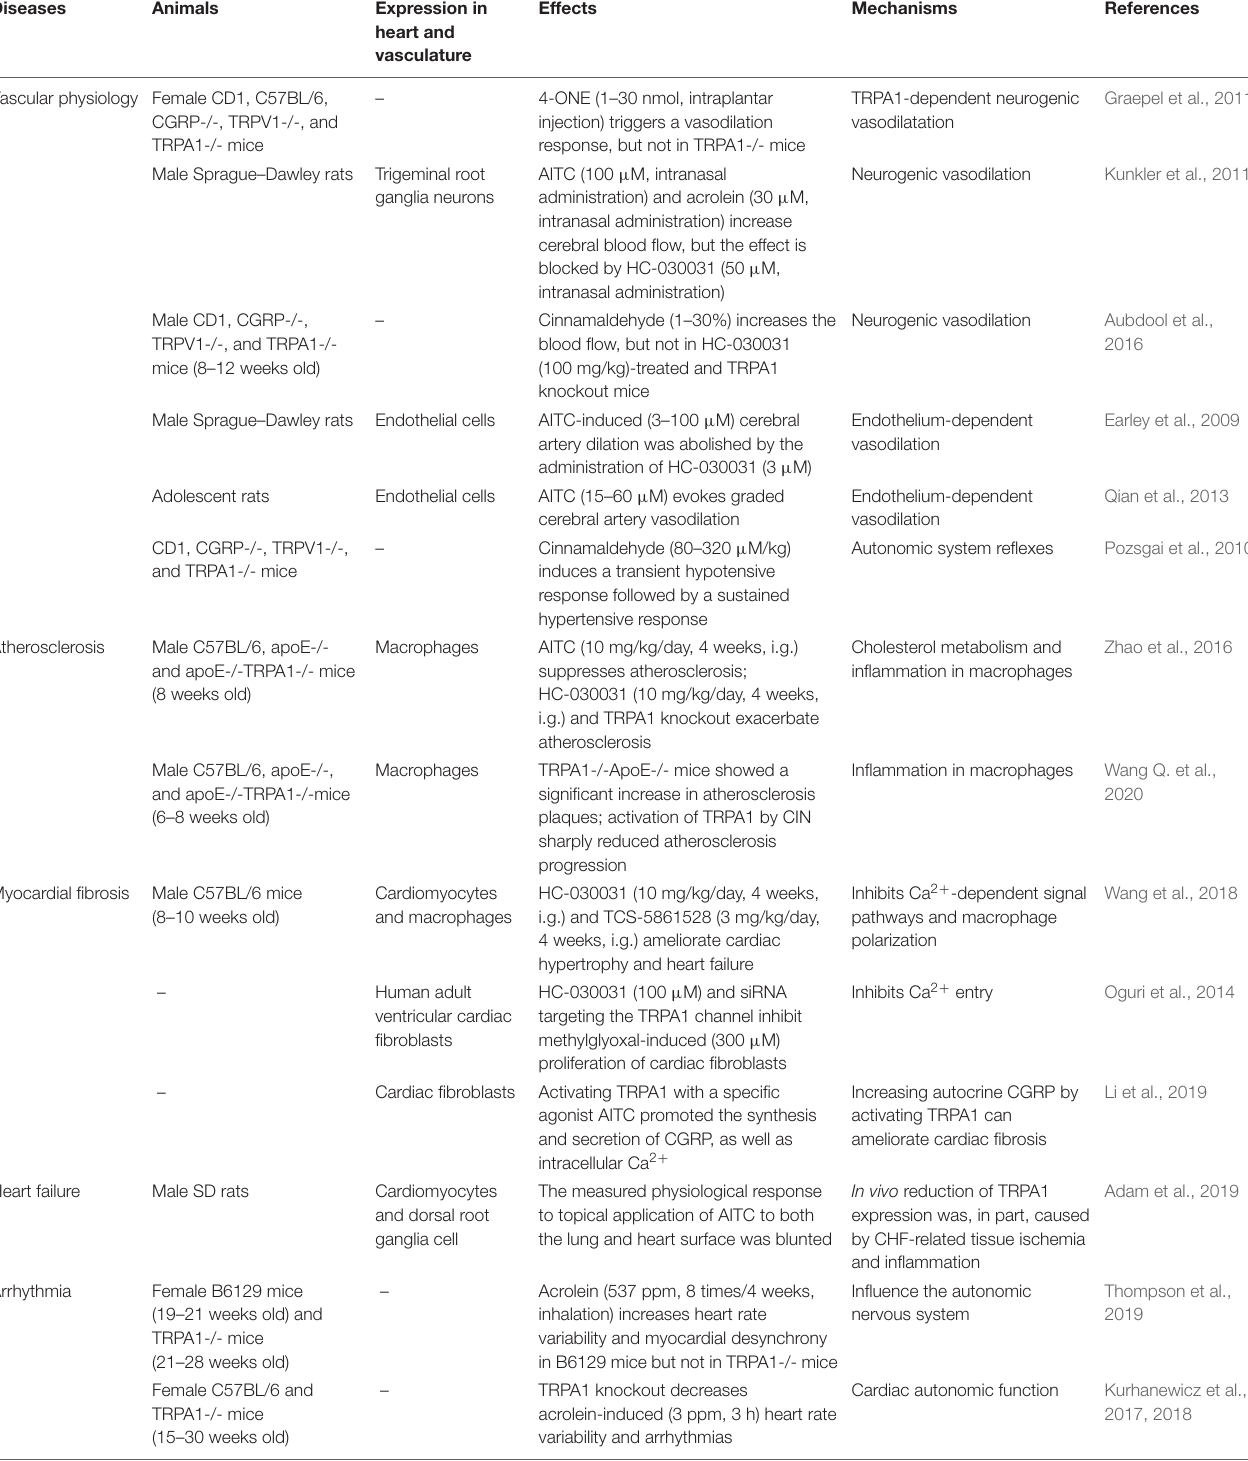
TABLE 1 | Role of the TRPA1 channel in the cardiovascular